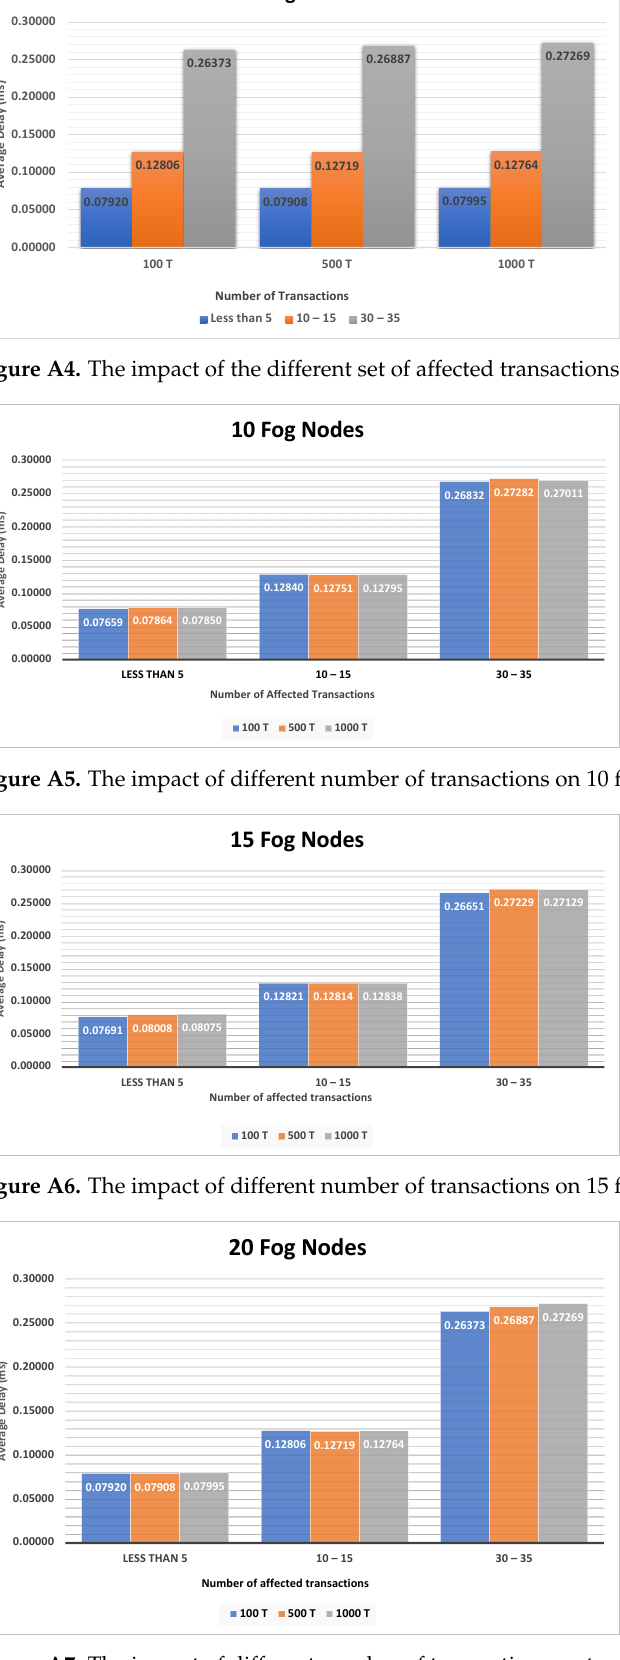
Figure A7. The impact of different number of transactions on twenty fog